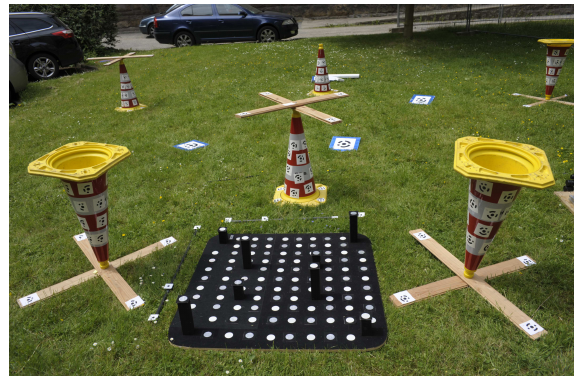
Figure 5: Calibration field for self-calibration approach with cones and thermal markers as reference targets for laser scanner and multispectral image point